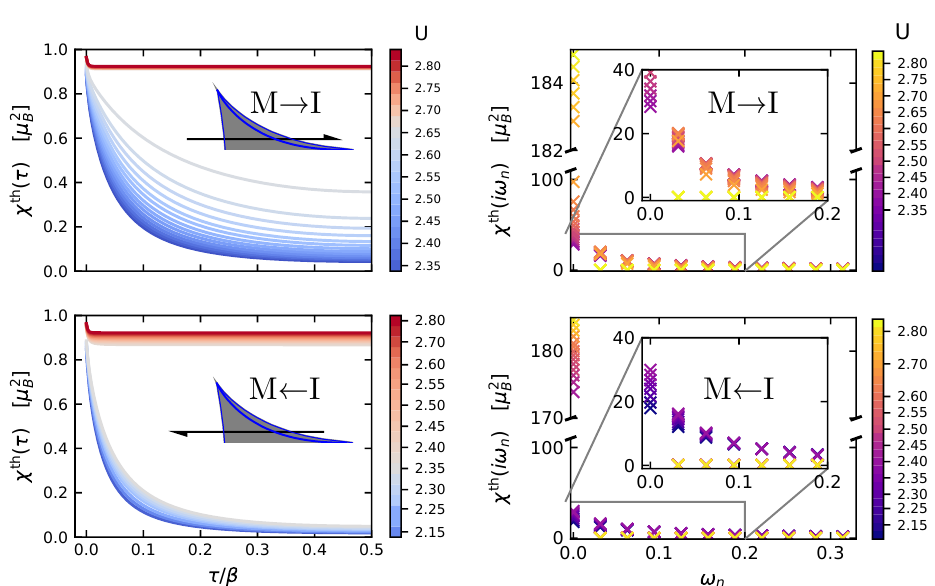
Figure 2: Spin susceptibility computed in DMFT as a function of imaginary time (left) and Matsubara frequencies (right) for T = 1 through the coexistence region of the 200 Mott MIT in the half-filled Hubbard model. For χ th ( τ ) the colorscale encoding the different values of U was set such that the grey color marks the crossing of the cor- ( T = 1 / 200 ) for the M → I path (top panel) and responding transition lines, i.e. U c 2 ( T = 1 / 200 ) for the M ← I path (bottom panel). The presence of an anomalous U c 1 term C (cid:54) = 0 should be suspected if a constant contribution to χ th ( τ ) (left) or a dis- continuity of the value at the zeroth Matsubara frequency (right) is identifiable in the